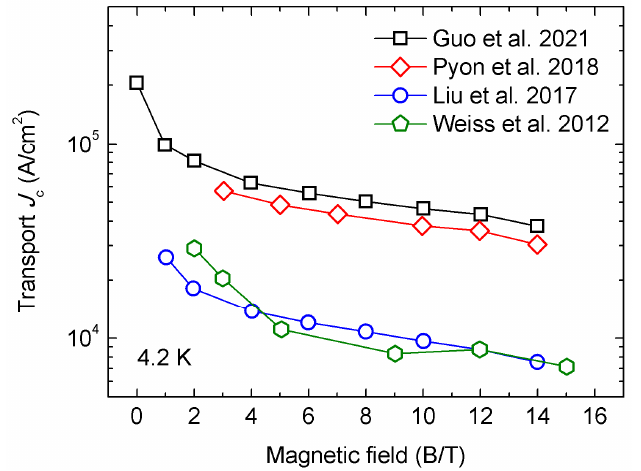
Figure 15. Comparison of the transport J c performance of HIP (Ba,K)Fe 2 As 2 superconducting wires from different groups [50,54,58,59].